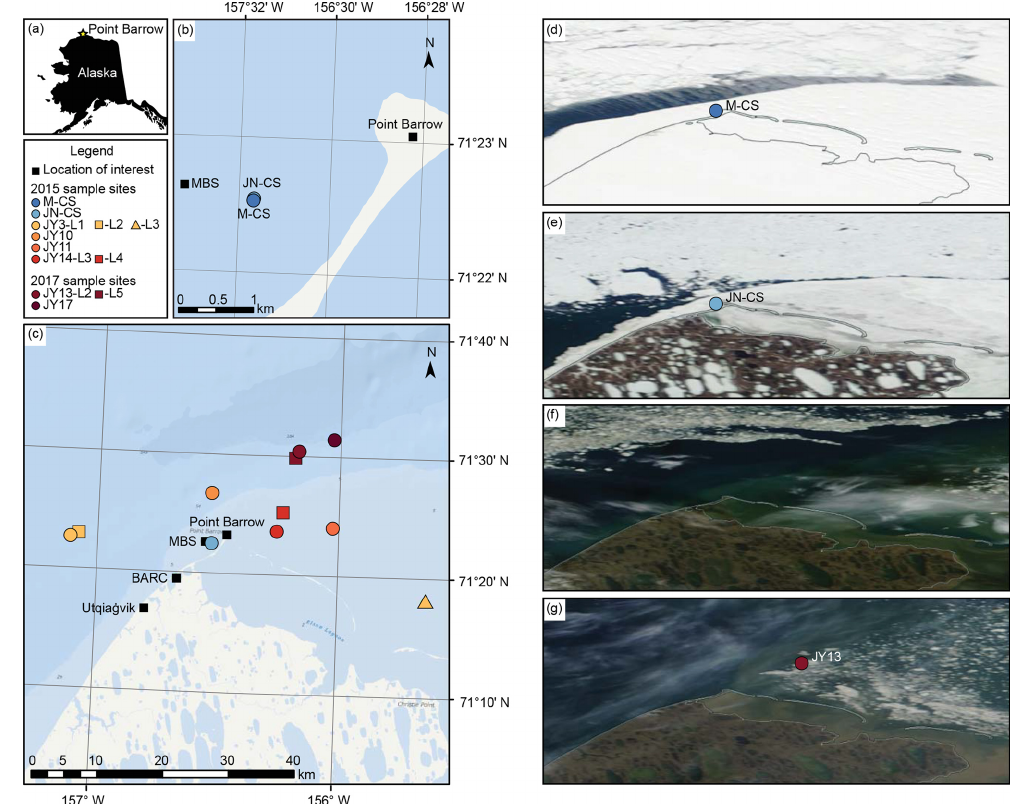
Figure 1. Map of sea ice sample collection sites. (a) Point Barrow (star). (b) Landfast sea ice sample collection sites for May 2015 (M- CS, dark blue) and June 2015 (JN-CS, light blue), shown relative to the 2015 SIZONet mass balance site (MBS) and Point Barrow. M-CS and JN-CS were separated by less than 30m. (c) Ice sample collection sites in May 2015 (dark blue), June 2015 (light blue), July 2015 (orange and red), and July 2017 (magenta) relative to Point Barrow, the 2015 MBS, the Barrow Arctic Research Center (BARC), and the town of Utqia˙gvik, Alaska, USA. (d–g) NASA MODIS satellite images of Point Barrow on clear-sky days on (d) 7 May 2015, showing the location of the M-CS sample site (dark blue); (e) 7 June 2015, showing the location of the JN-CS sample site (light blue); (f) 6 July 2015, showing the general locations of highly mobile ice proximal to Point Barrow (cloud cover obscures the region during the days samples were collected in July 2015); and (g) 13 July 2017, showing the location of the JY-13 sample site (magenta). No clear-sky images were available for the July 2015 sampling dates (JY3, JY10, JY11, and JY14) or for 17 July 2017 (JY17). Maps (b–c) were constructed using ArcMap ™ 10.5.1 (Environmental Systems Research Institute, Redlands, CA, 2017), with the Alaska Coastline 1 : 63360 base map (Alaska Department of Natural Resources, Information Resource Management, http://asgdc.alaska.gov/#56, 1998, last access: 28 July 2017). Satellite imagery in (d–g) retrieved from https://worldview.earthdata.nasa.gov (last access: 20 May 2017), coastline overlay OpenStreetMap© contributors, available under the Open Database